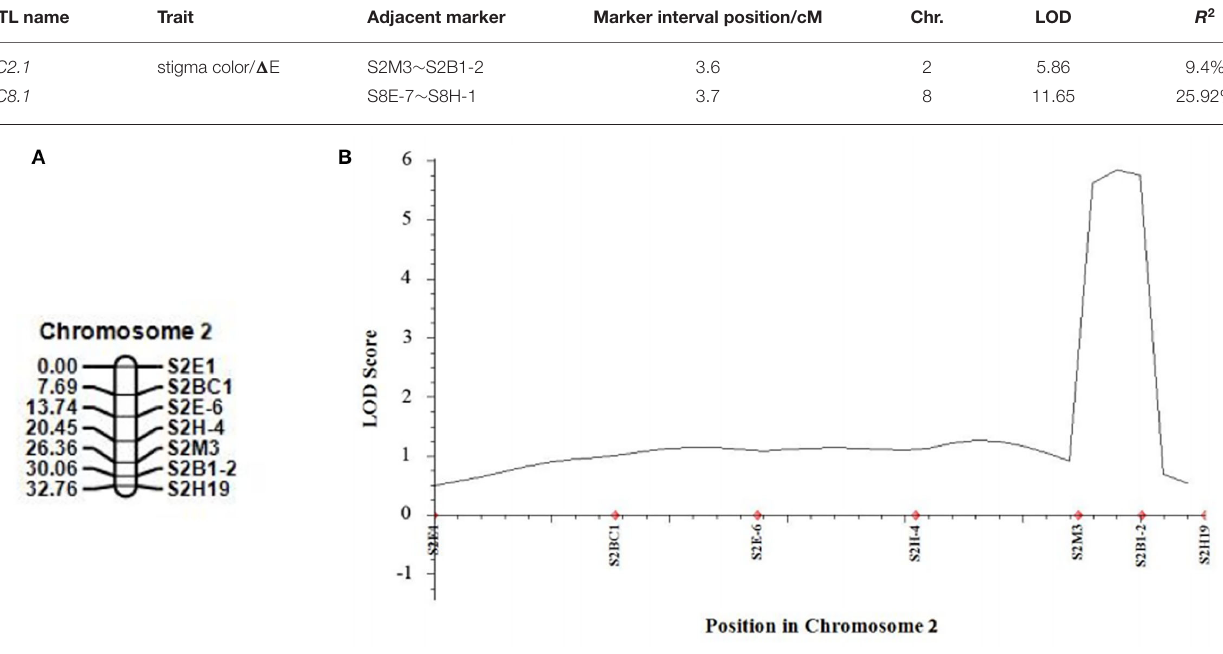
FIGURE 4 | Validation of the stigma color quantitative trait loci (QTL) in melon. (A) Linkage map of melon chromosome 2, based on 540 F 2 individuals derived from a cross between MR-1 and M4-7. (B) QTL curve for melon stigma color.